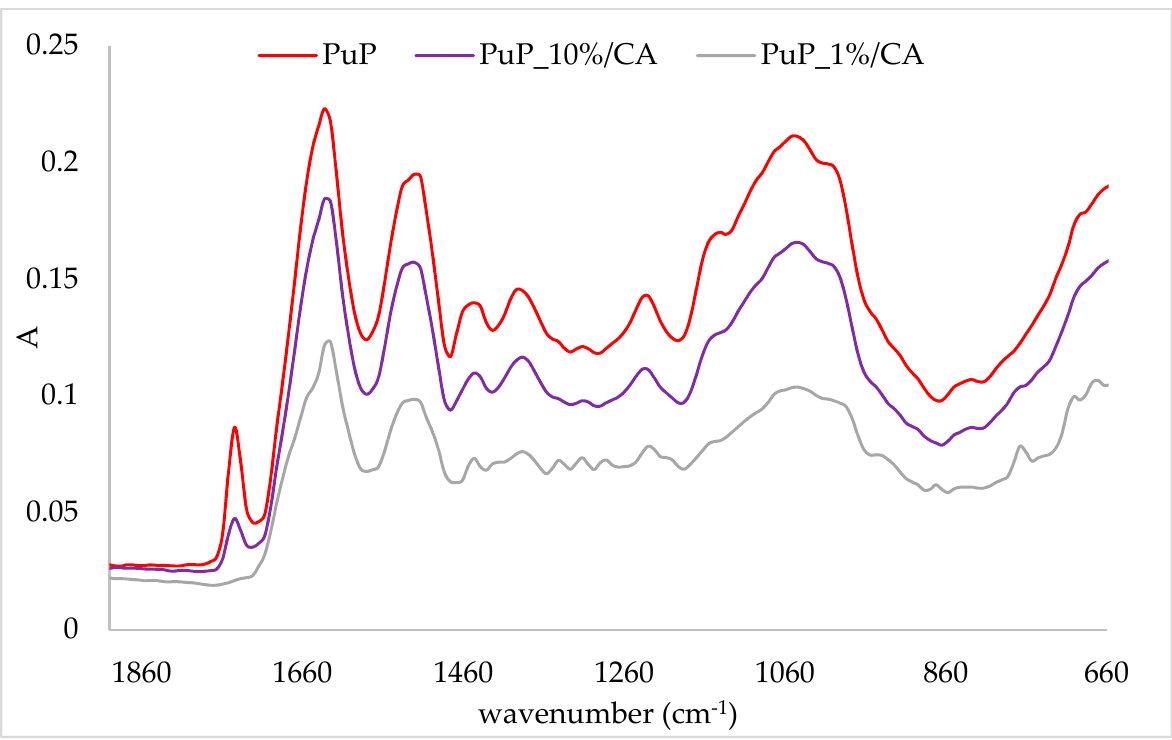
Figure 2. IR spectra of almond protein (AP) and obtained complexes with cinnamic acid (AP_10%CA—complex prepared with 10% of protein matrix; AP_1%CA—complex prepared with 1% of protein matrix).